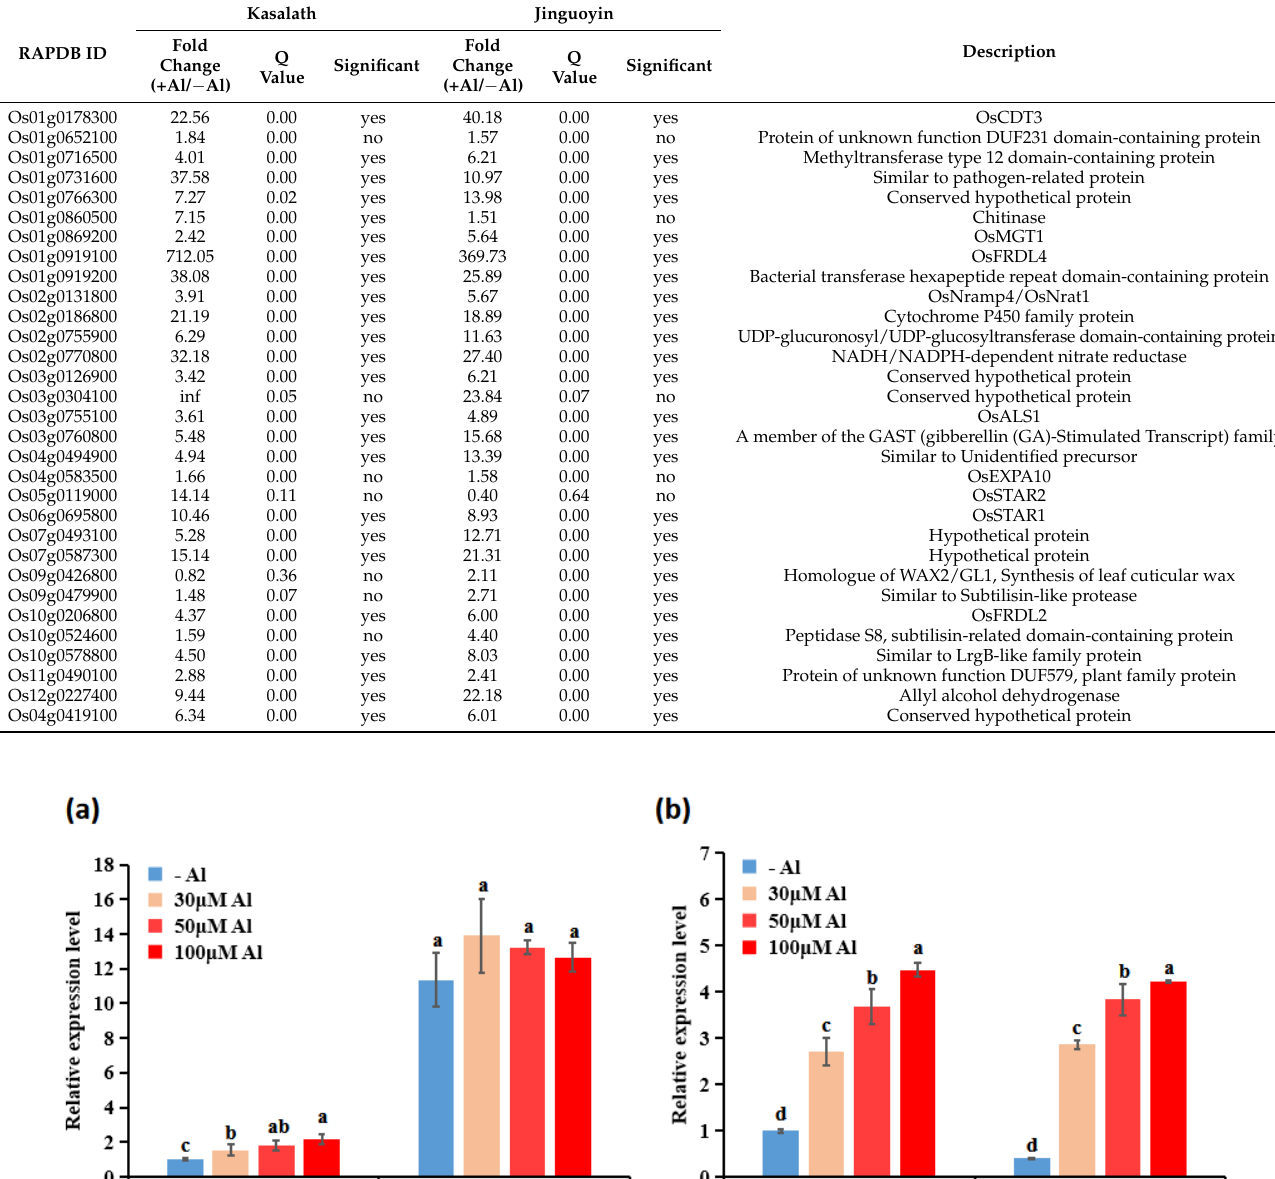
Table 1. Expression changes of ART1-regulated genes in the root tips of Kasalath and Jinguoyin. RNA sequencing was performed with Kasalath and Jinguoyin exposed to 50 µ M AlCl 3 for 6 h with four replicates.